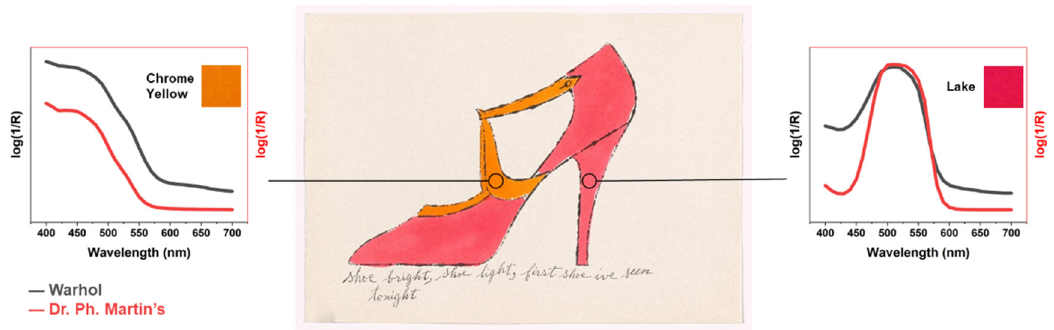
Figure 5. Identification of Dr. Ph. Martin’s Synchromatic Transparent Water Colors in a plate from À la Recherche du Shoe Perdu non-invasively by reflectance spectrophotometry. © 2022 Andy Warhol Foundation for the Visual Arts/Artists Rights Society (ARS), New York, All reproductions of this work are excluded from the CC: BY License.